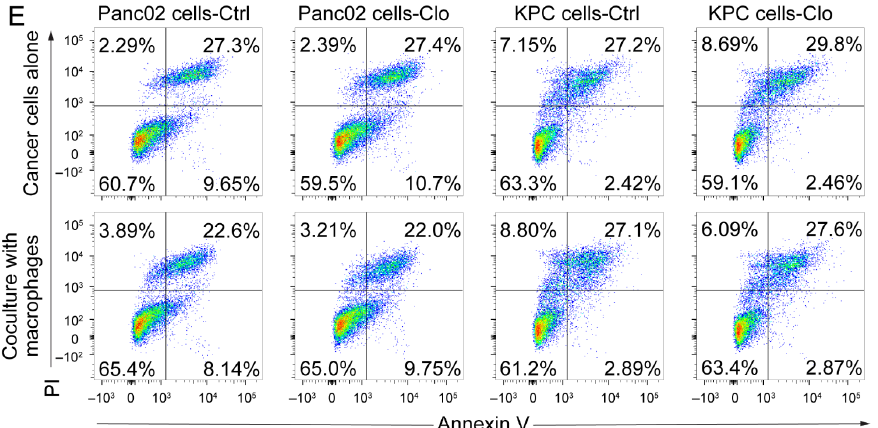
Figure 2. Macrophages exerted a protumor effect in vivo. ( A ) Schematic diagram of our strategy used to target macrophages. C57BL/6 mice were implanted subcutaneously (s.c.) with a KPC-derived tumor cell line or Panc02 cells on day 0, and the mice were treated with either control liposomes or clodronate liposomes at the indicated times by intraperitoneal injection (each 200 µ L) ( n = 7 per group). ( B ) Immune cells isolated from splenocytes were stained with antibodies for the markers CD45, CD11b, and F4/80 and assessed by flow cytometry analysis. The frequency of macrophages (CD11b + F4/80 + ) is expressed as a percentage of the gated CD45 + cell population in each plot. ( C , D ) Left: tumor growth curves showing the volumes of subcutaneously implanted tumors in mice ( n = 7 per group) treated with control or clodronate liposomes. Right: final tumor weights. ( E ) Top: necrosis and apoptosis of Panc02 and KPC cells after directly treated Panc02 and KPC cells with or without clodronate liposomes determined using Annexin V and PI FACS analysis. Bottom: coculture Panc02 or KPC with macrophages isolated from murine tumor tissues, treated with liposomes. Data are shown as the mean ± SEM. Statistical analyses were carried out by Student’s t test. *: p ≤ 0.05, **: p ≤ 0.01, ***: p ≤